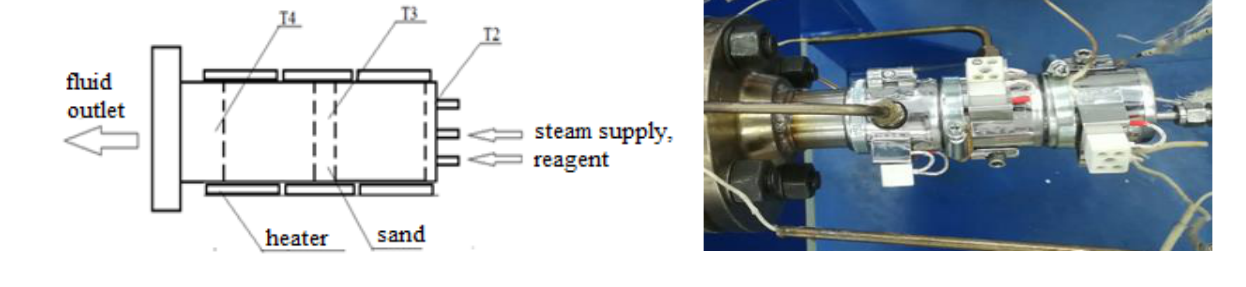
Figure 1. The layout of the thermocouples in the core holder.